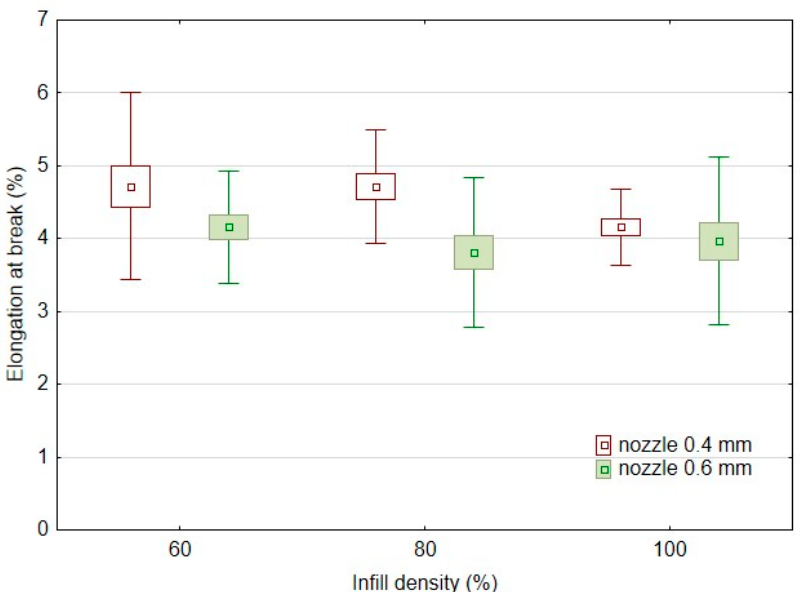
Figure 4. Influence of infill density on tensile strength in static testing using FDM 3D printing with different nozzle diameters.